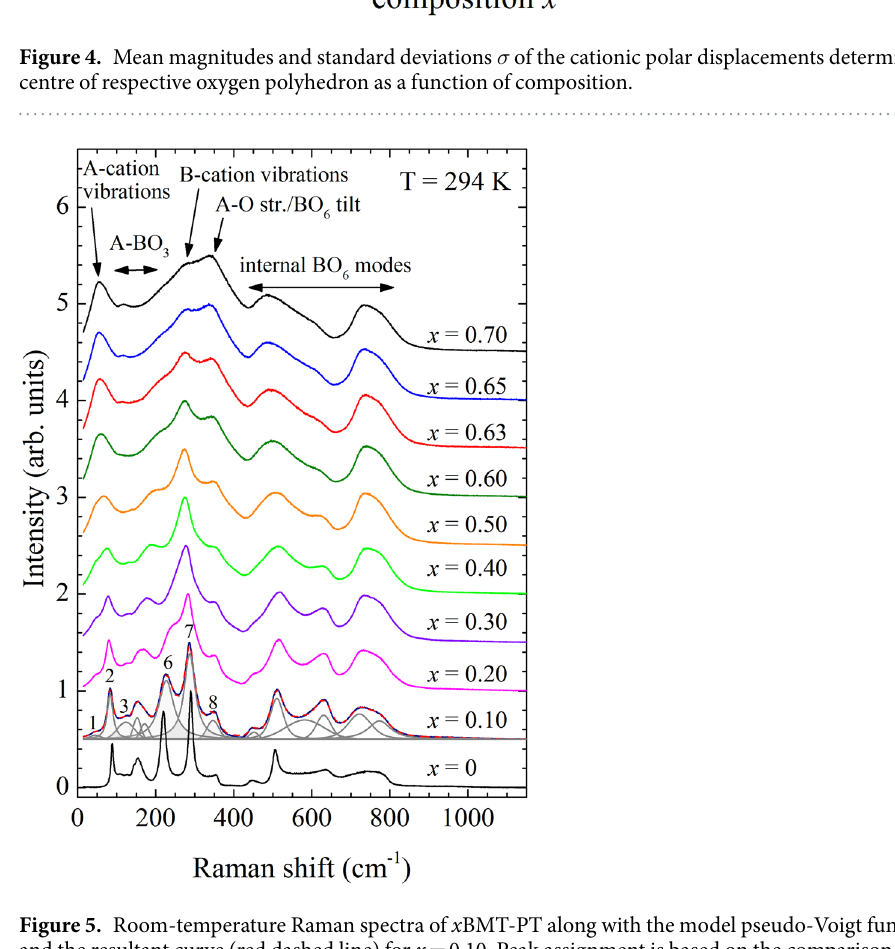
Figure 5. Room-temperature Raman spectra of x BMT-PT along with the model pseudo-Voigt functions and the resultant curve (red dashed line) for x = 0.10. Peak assignment is based on the comparison with other complex perovskite-type ferroelectrics 50, 51